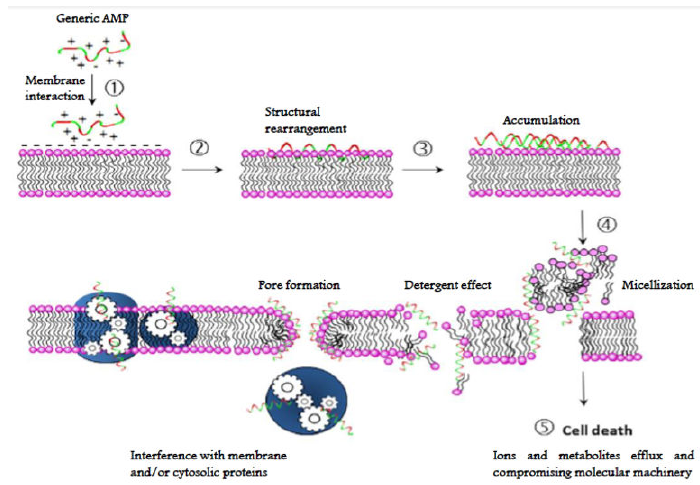
Figure 7. Generalized mode of action of AMPs. (1) Electrostatic and hydrophobic interaction with cell surface; (2) conformational rearrangement and membrane insertion; (3) accumulation to a threshold level (4) membrane alteration (pore or lesion formation, detergent effect, micellization, etc.) leading to permeabilization and/or depolarization. Membrane or cytoplasmic protein machinery may also be disrupted; (5) inactivation of the